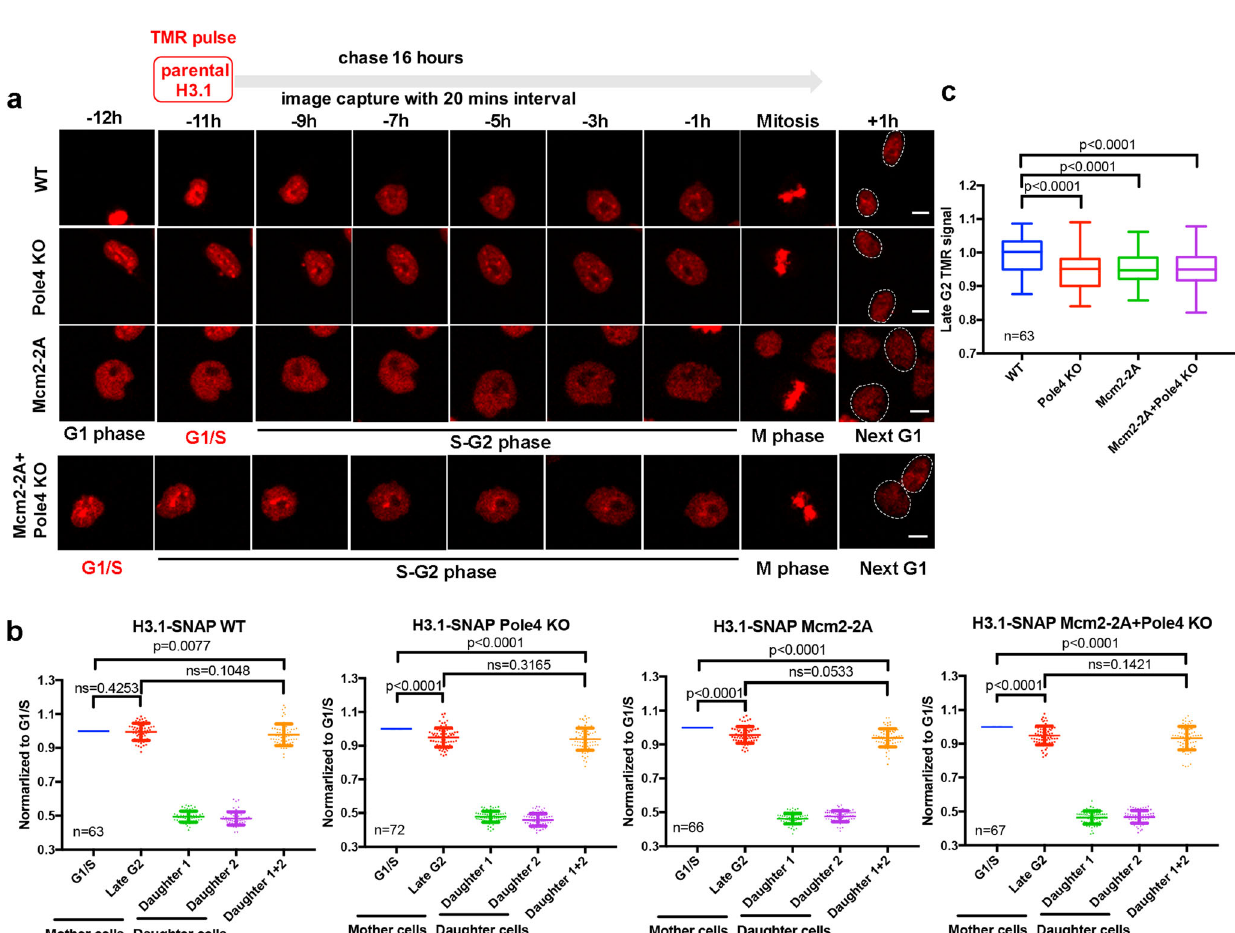
Fig. 1 Parental H3.1 and H3.3 are faithfully recycled following one cell division. a An outline of experimental procedures for the quanti fi cation of parental H3.1 and H3.3 during one cell division. H3.1-SNAP or H3.3-SNAP-tagged cells were labeled with TMR. After washing out TMR substrates, live-cell images were captured continuously for 16 h. Cells that showed TMR signals more than 11 h before mitosis (G1/S) and more than 1 h after mitosis (next G1) were chosen for analysis of the integrated intensity of H3.1-SNAP and H3.3-SNAP signals at G1, G2, and next G1. b Parental H3.1 are stably recycled following DNA replication and equally distributed to two daughter cells. Upper: representative live-cell images of TMR-labeled-parental H3.1 at the indicated time points in mES cells expressing H3.1-SNAP ( n = 56). The number denotes time in hours in reference to mitosis. Scale bar, 10 µ m. Lower: integrated TMR signals normalized to G1/S time point at three time points: G1/S, Late G2 and next G1 with two daughter cells. Relative TMR signals at G1/S, G2 in each individual cell and those in daughter 1 and 2 are shown. c Quanti fi cation of parental H3.1-SNAP signals at different phases of the cell cycle. Parental H3.1-SNAP fl uorescence in each cell was measured in the entire nucleus at G1/S, G2, daughter cell 1 and 2 and normalized to that mother cell at G1/S. d Parental H3.3 are stably recycled following DNA replication and equally distributed to two daughter cells. Upper: representative live-cell images of parental H3.3 at the indicated time points in cells expressing H3.3-SNAP ( n = 66). Scale bar, 10 µ m. Lower: relative TMR signals at G1/S, G2 in each individual cell and those in daughter 1 and 2 are shown. e Quanti fi cation of parental H3.3 signals at different phases of the cell cycle. The experimental procedures mirror that described in ( c ). b – e n number of cells from two independent experiments. c , e Data are presented as means ± SD. Two-tailed